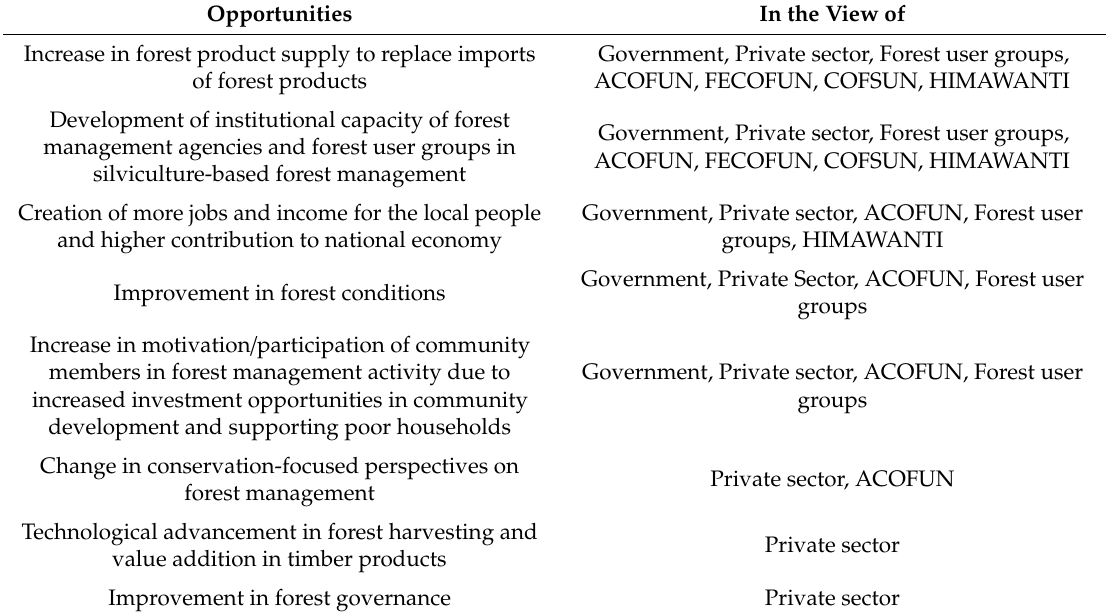
Table 3. Stakeholders views on key opportunities of SciFM